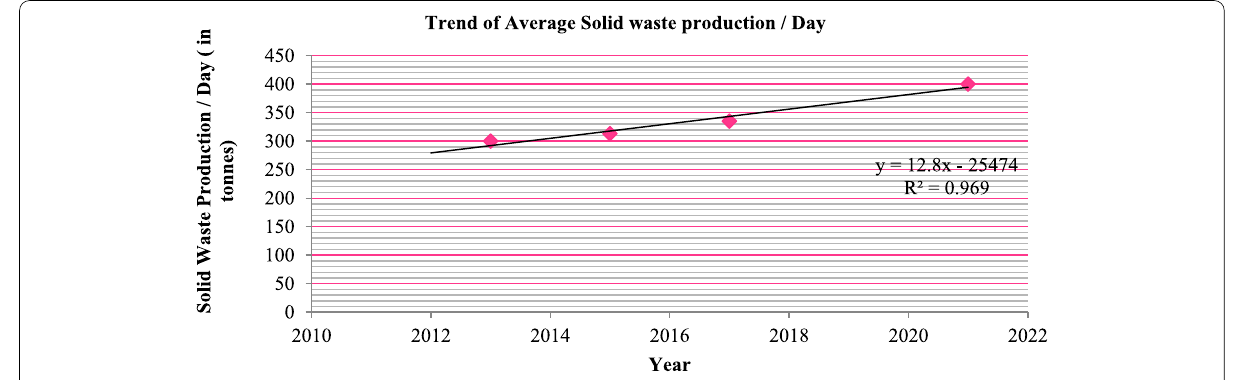
Fig. 2 Trend of Average Solid Waste production / Day in Siliguri Municipal